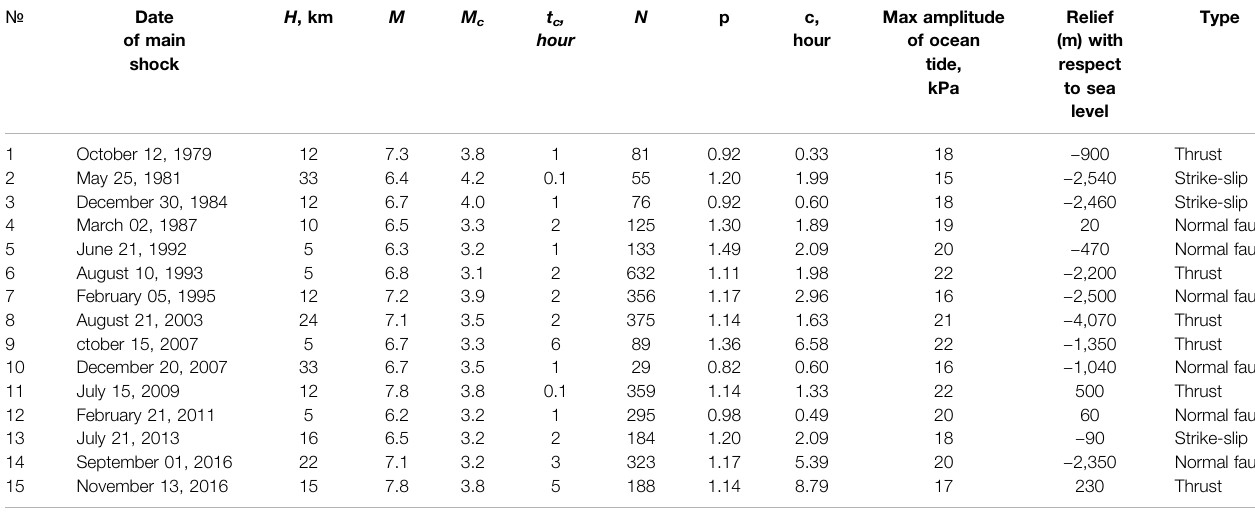
TABLE 3 | The main parameters of the aftershock sequences for New Zealand. H denotes the mainshock depth of focus; M is the mainshock magnitude (magnitude M L as converted from energy class in Table 2 ); N denotes the number of M ≥ M C aftershocks in the interval ( t c , 720 h) measured from the mainshock time; the maximum amplitude of ocean tide in the interval ( t c , 720 h) measured from mainshock time was converted to pressure, kPa; relief at the epicentre ofmain event (m) with respect to sea level; type indicates the focal mechanism of the main event.